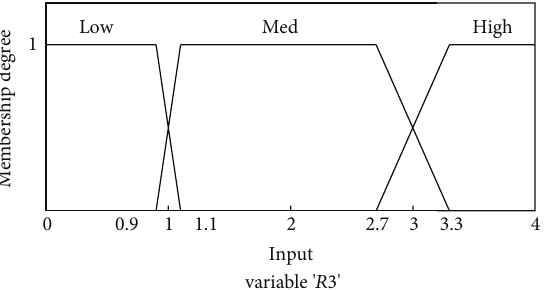
Figure 2: Membership function for ratio 𝑅3